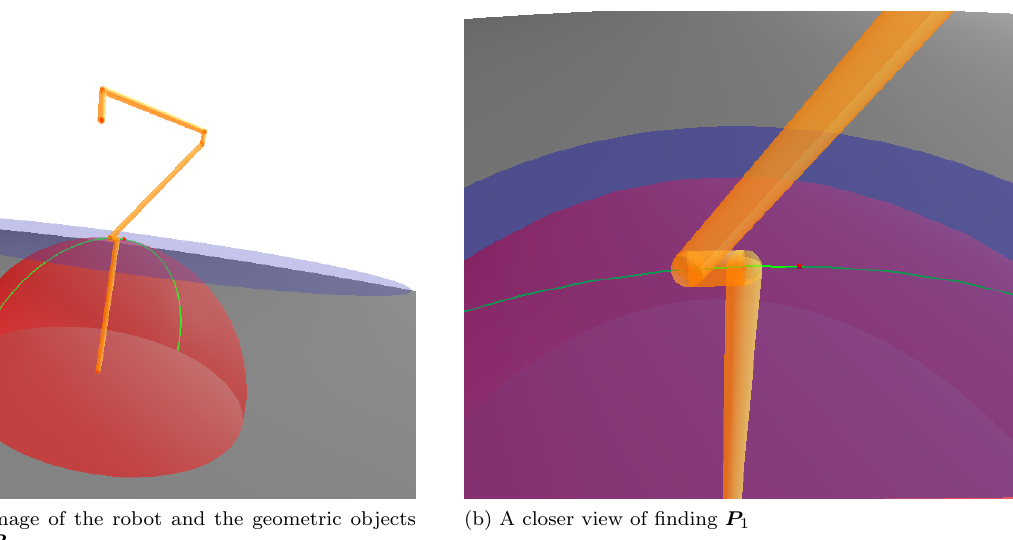
Figure 3: The red sphere is S 0 , the blue plane is Π 1 x , the green circle is generated from S 0 ∧ Π c , and the red point pair is Q 1 , where one is picked to be P 1